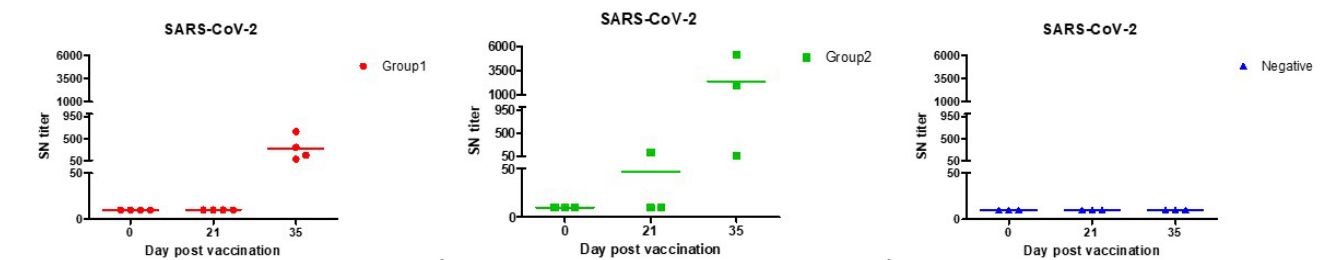
Figure 4. SARS-CoV-2 neutralization antibody forming rates with each of the beagles. Both Group